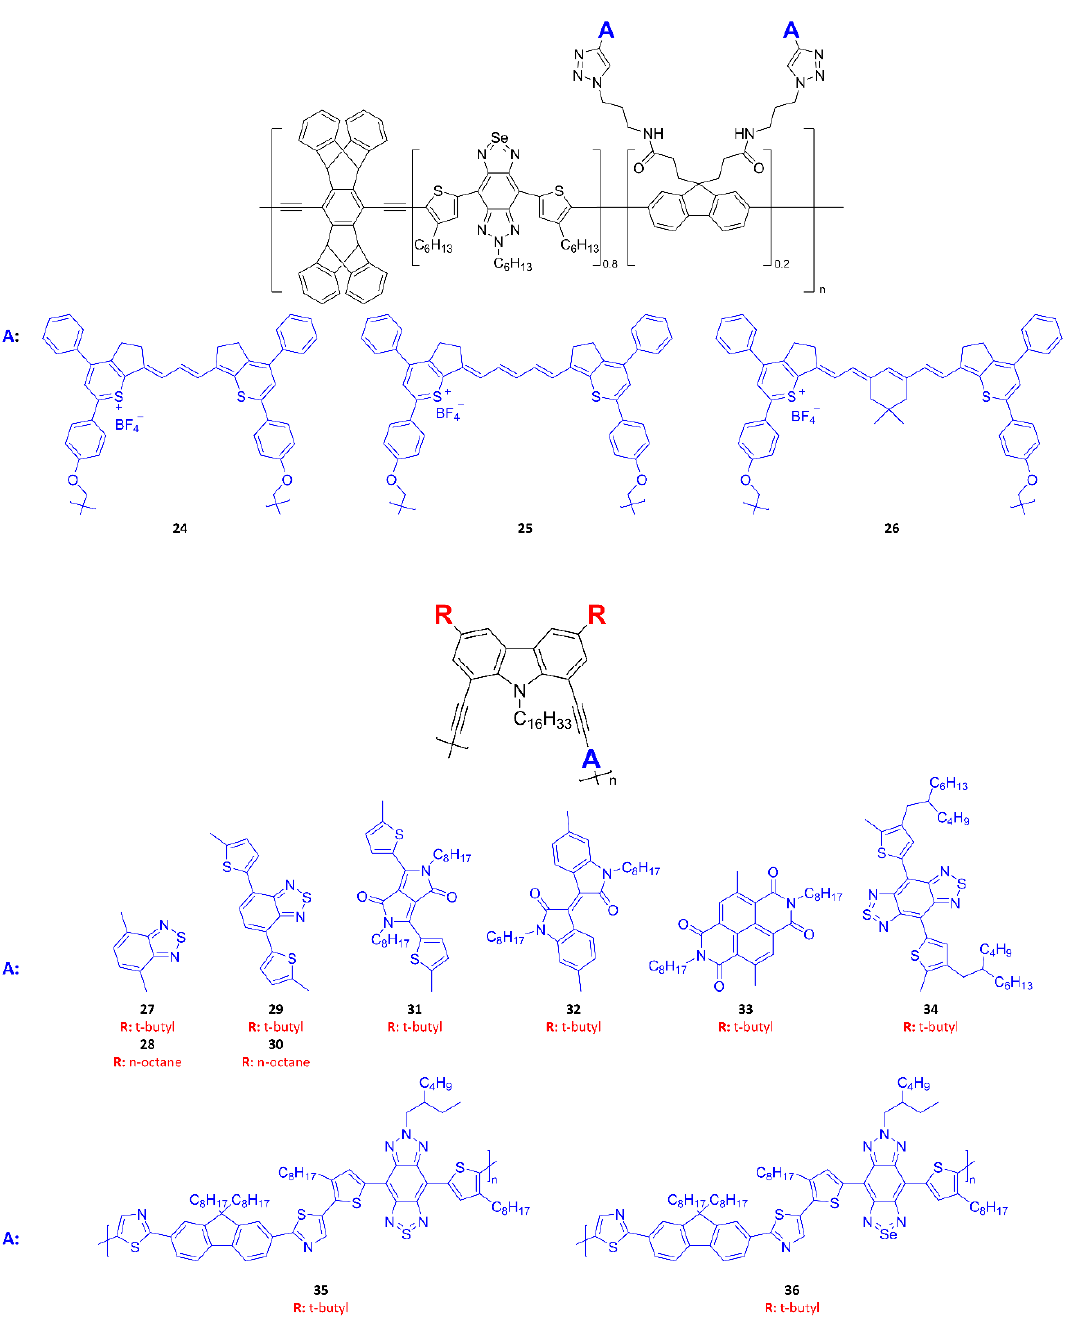
Figure 14. Chemical structures of the polymer probes constituting polymer dots, via the strategy of tuning the alkyl structure to change their optical properties.